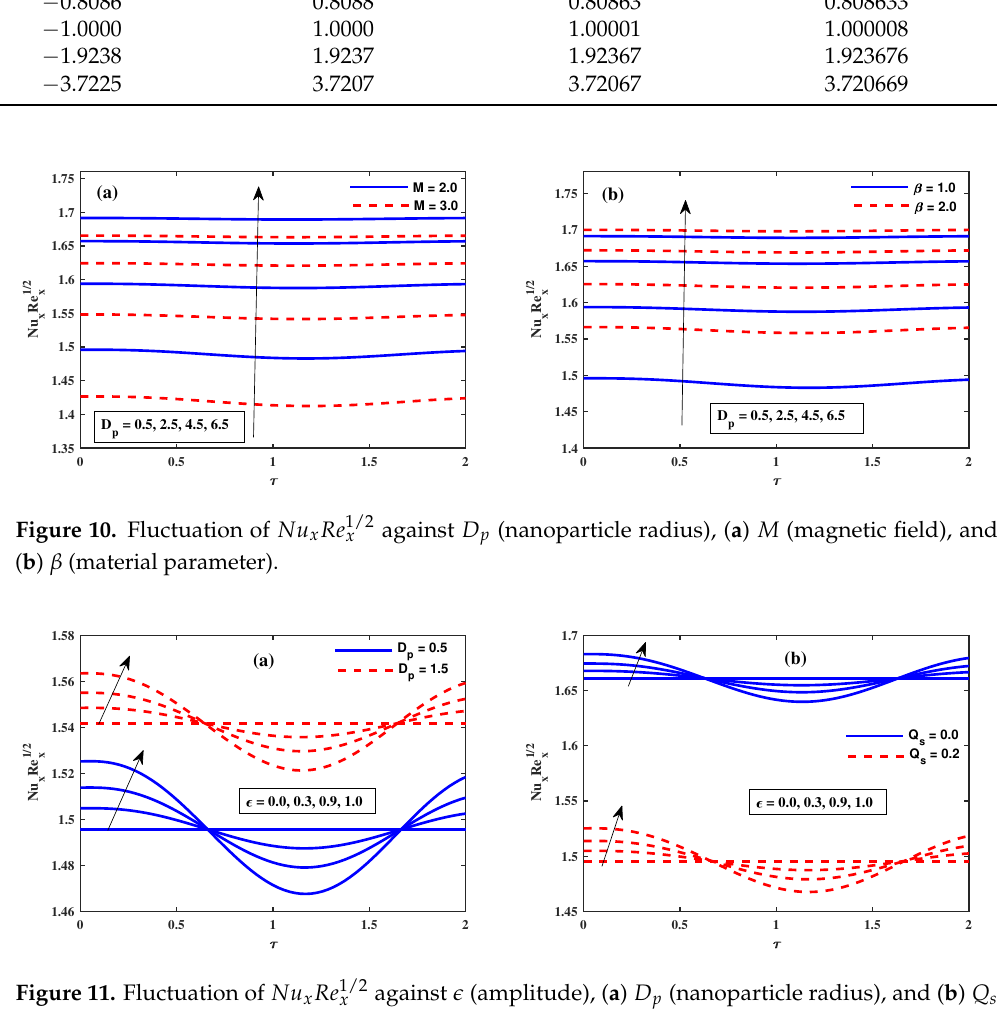
Figure 11. Fluctuation of Nu x Re 1/2 x against (cid:101) (amplitude), ( a ) D p (nanoparticle radius), and ( b ) Q s (heat